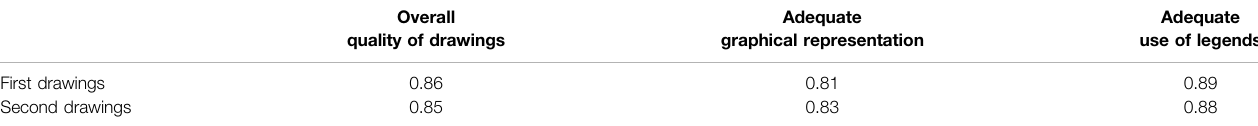
TABLE 1 | ICCs between the four coders using the “ sort-resort ” technique on three criteria for the fi rst and second drawings.